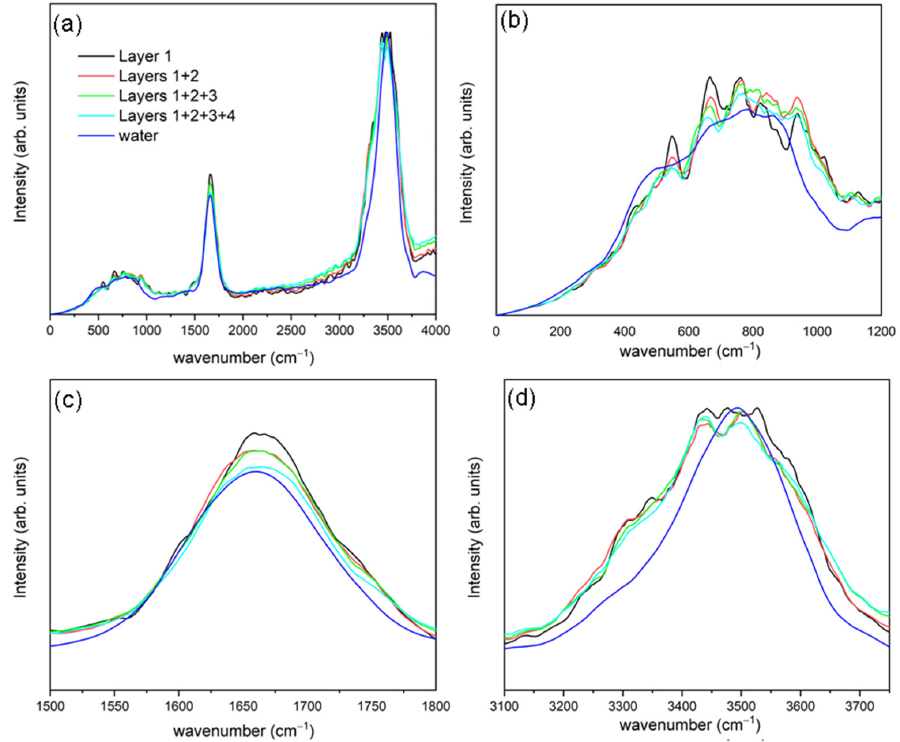
Figure 5. Full infrared spectra ( a ) and subsets for low-frequency region ( b ), H-O-H bending region ( c ) and H-O stretching region ( d ) for the water interfaces with one (black), two (red), three (green) and four (light blue) solvation layers in contact with the ubiquitin and liquid water (blue).